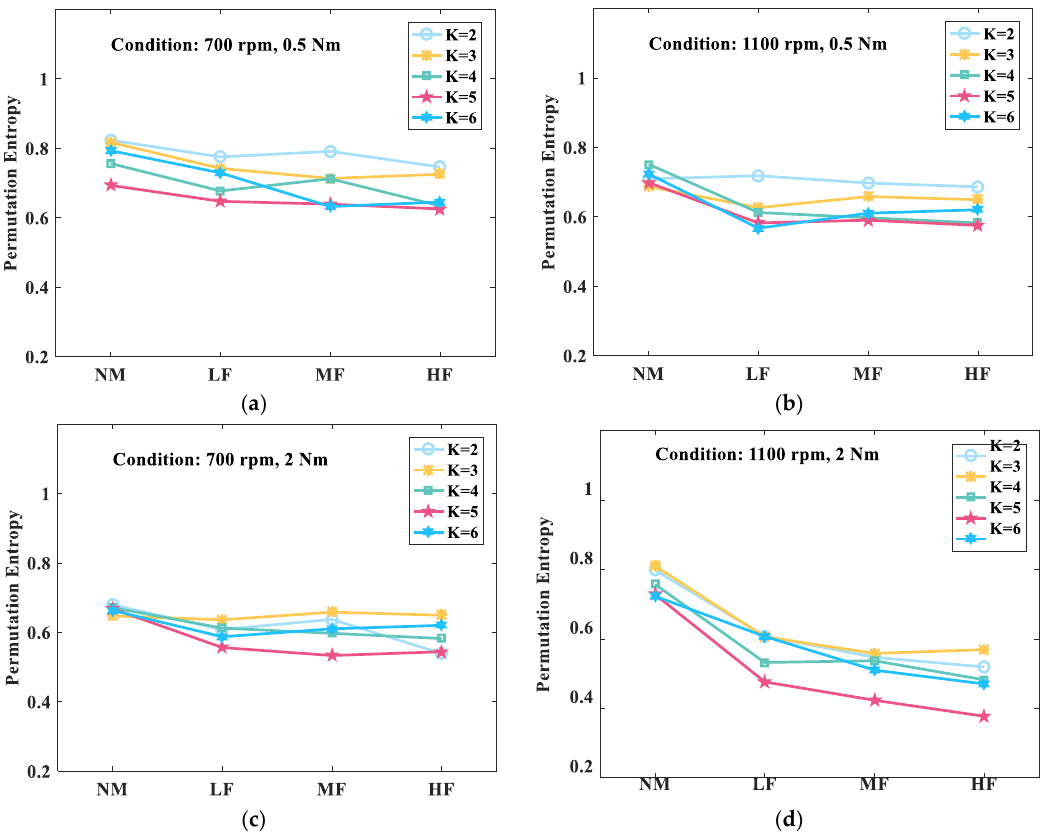
Figure 4. The permutation entropy with varying decomposed levels under different conditions. ( a ) Condition in 700 rpm/0.5 N·m; ( b ) condition in 1100 rpm/0.5 N·m; ( c ) condition in 700 rpm/2 N·m; ( d ) condition in 1100 rpm/2 N·m.